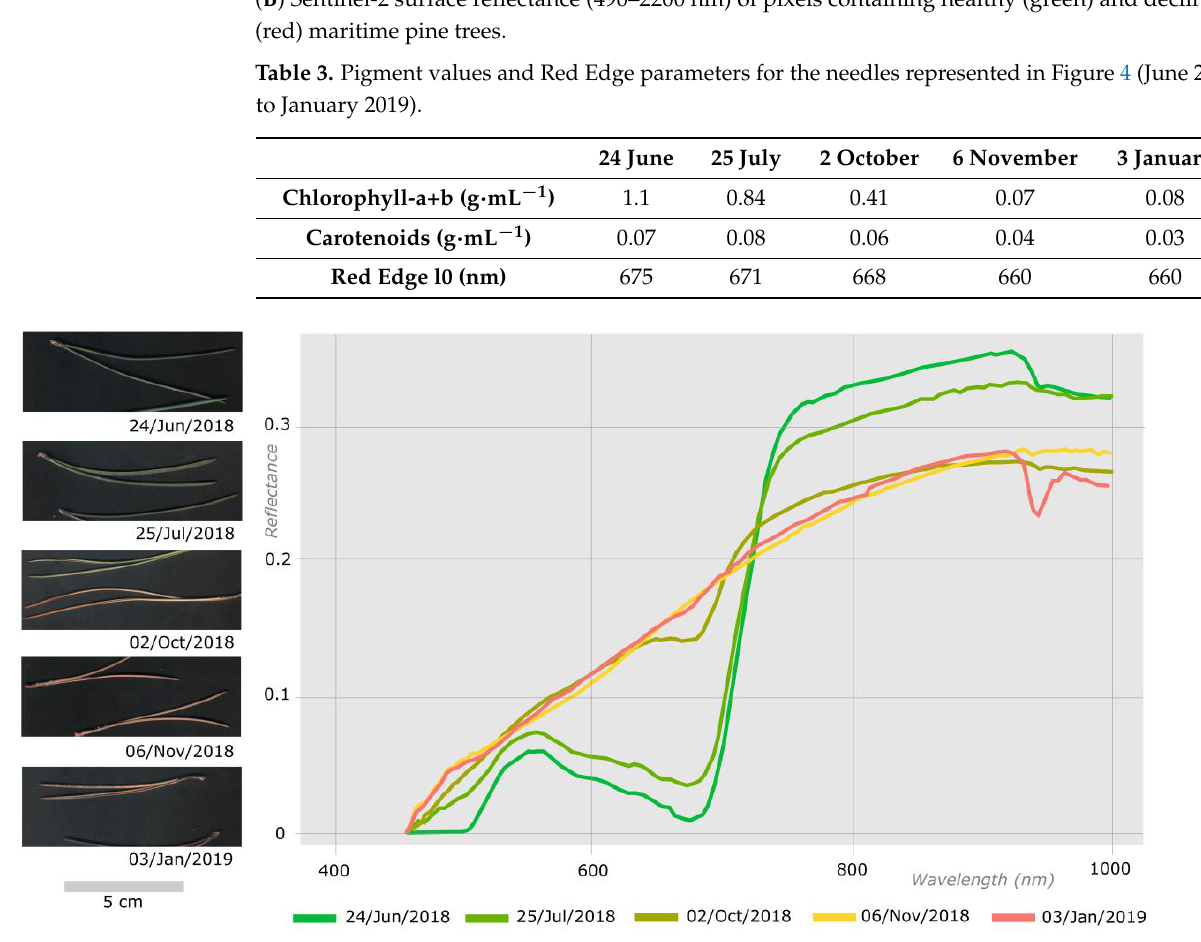
Figure 4. Average needle reflectance and scans of a maritime pine tree with confirmed natural infection by Bursaphelenchus xylophilus (ITR49). Notice the pre-visual spectral changes noticeable in the spectra recorded on 25 July. Table 3. Pigment values and Red Edge parameters for the needles represented in Figure 4 (June 2018 to January 2019).